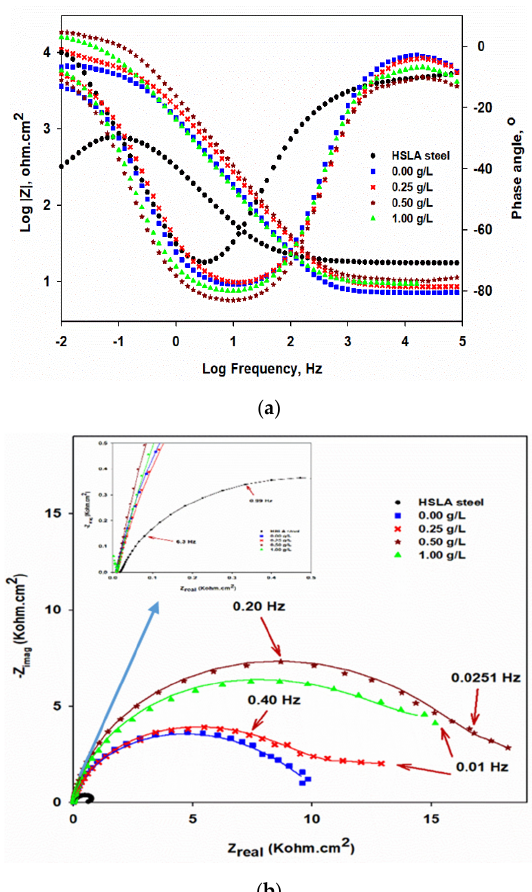
Figure 8. ( a ) Bode-phase angle and ( b ) Nyquist-plots of the HSLA steel, NiP, and NiP-TNPs (NiP-0.25TNPs, NiP-0.50TNPs, and NiP-1.0TNPs) nanocomposite coatings with different content of TNPs that immersed in 3.5 wt. % NaCl solution at 25 °C. The inset in b is the enlargement of the low impedance regions.